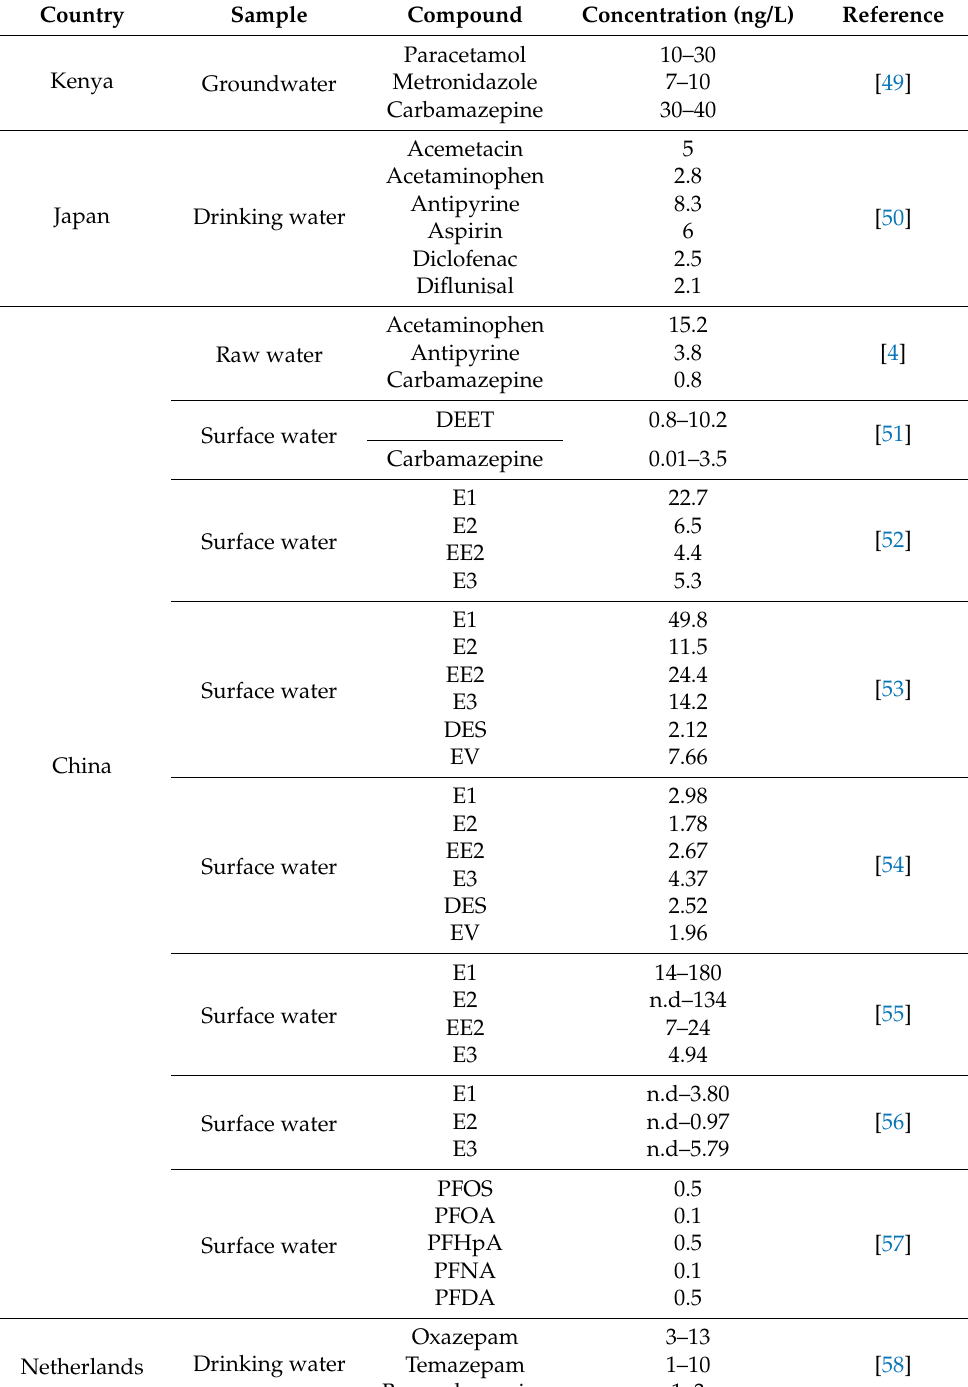
Table 2. Concentrations of EPs in water samples